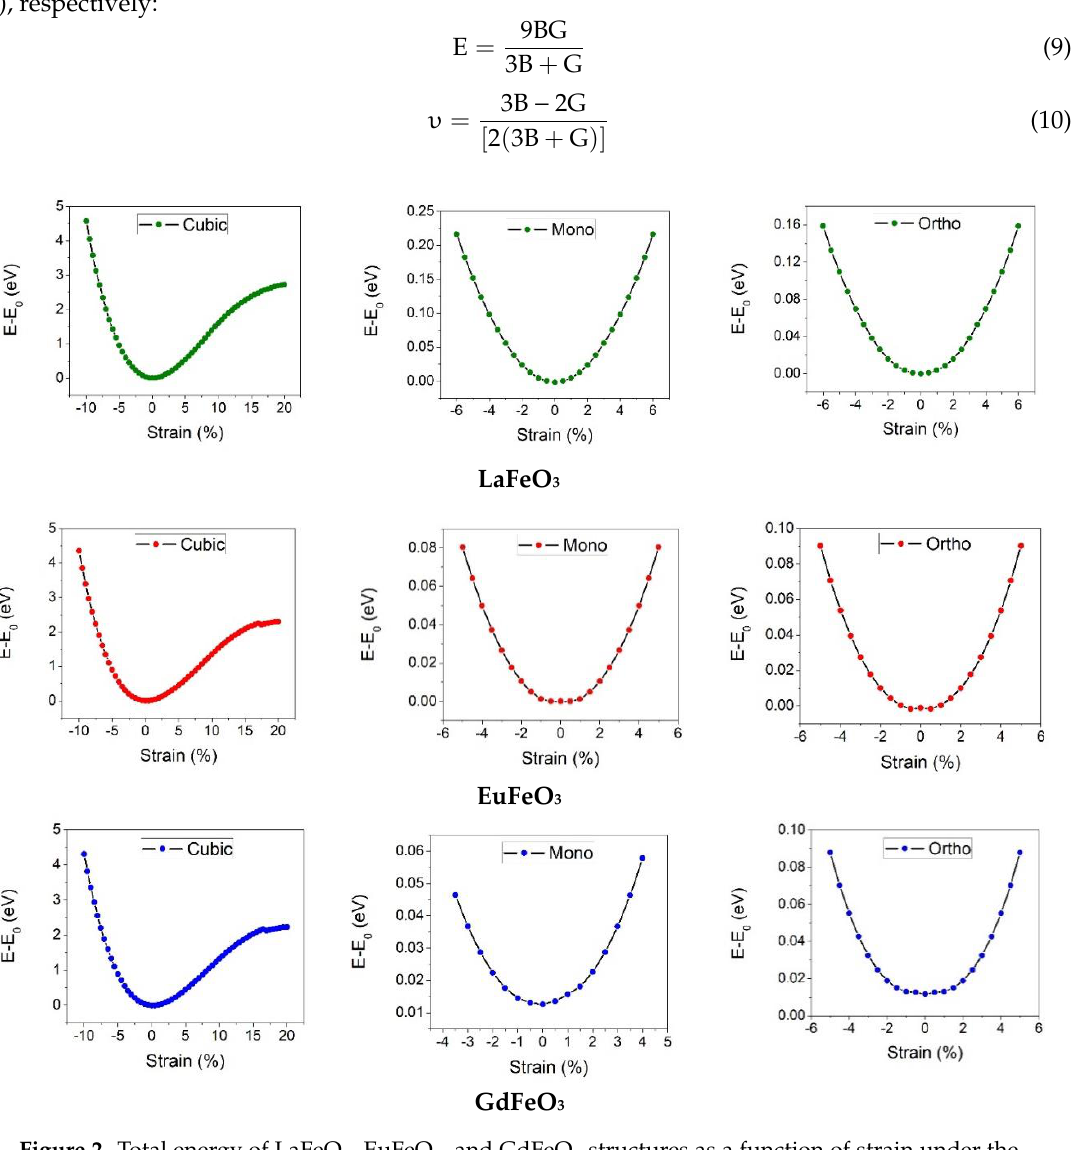
Table 4. Values of shear velocity (V t ), compressional velocity (V l ), sound velocity (V m ), and the Debye Temperature (θ D ) of RFeO 3 (R = La, Eu, Gd) compounds.